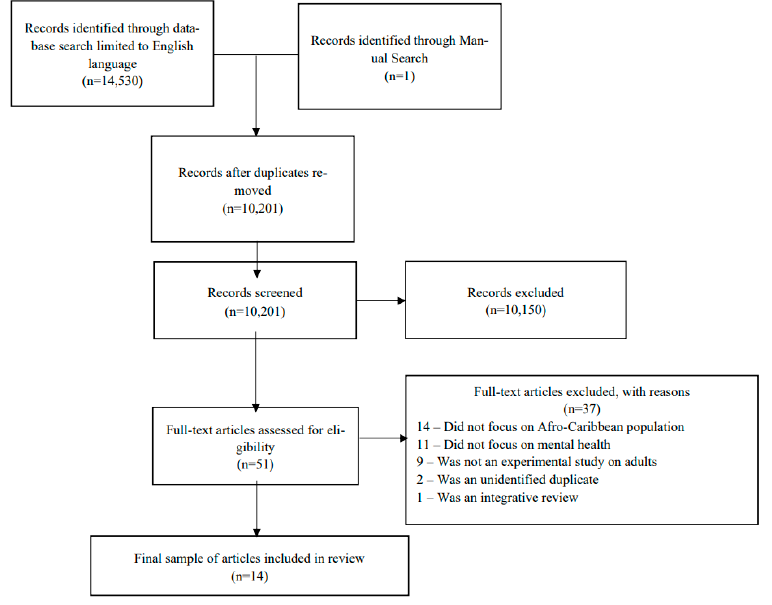
Figure 1. Prisma Flow Sheet.